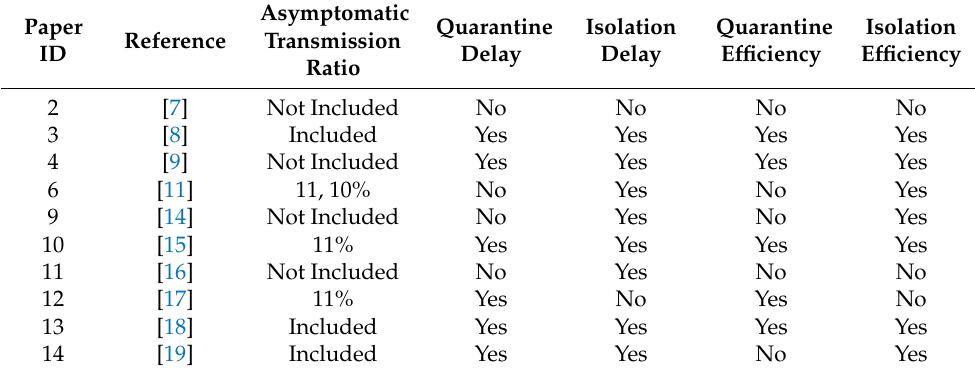
Table 2. Comparison of SARS and SARS-CoV-2 Epidemiological